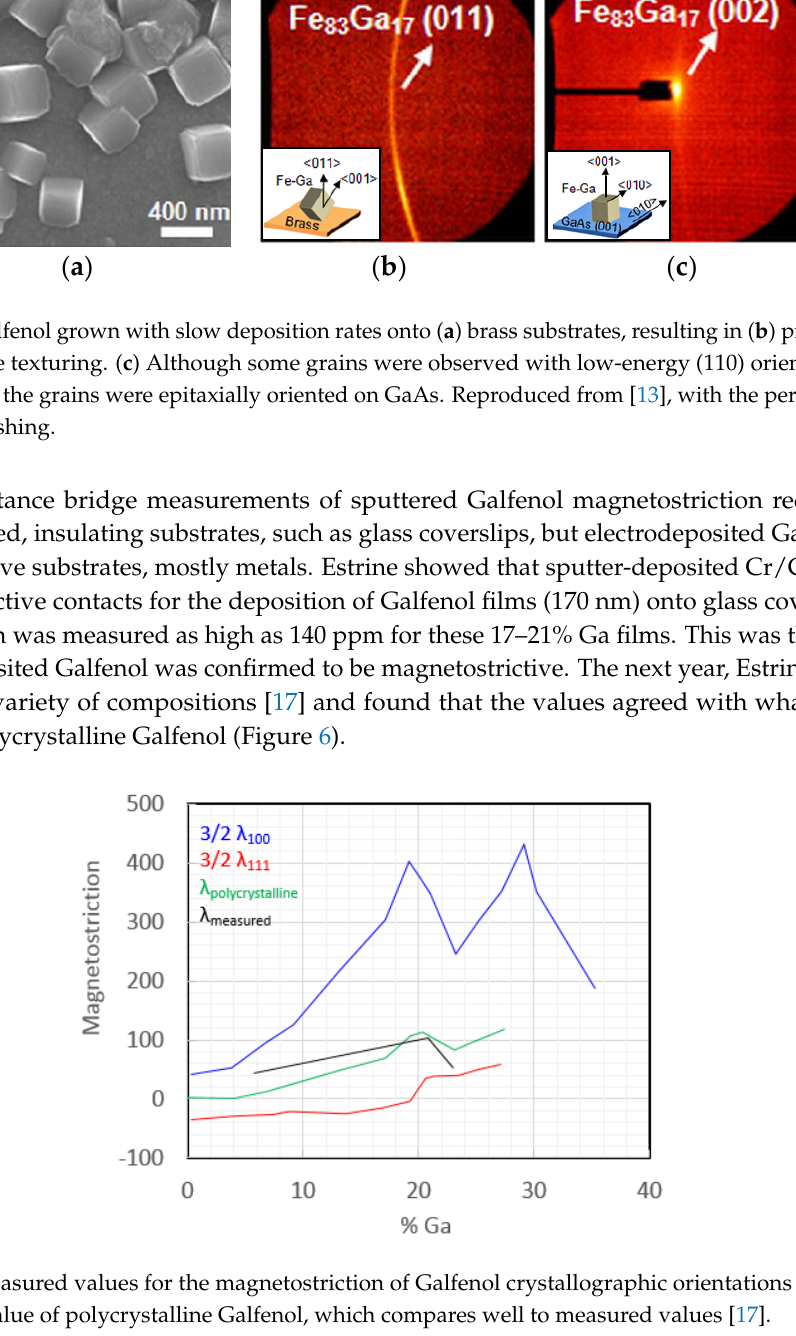
Figure 4. Due to differences in mass transport rates, the composition of Galfenol films can be tailored simply using the rotation rate ( ω ) of a rotation disk electrode [14].